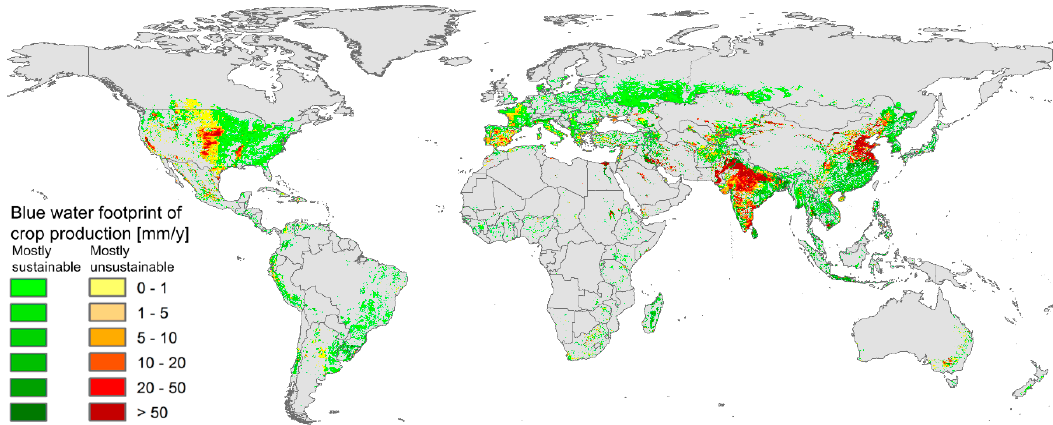
Figure 4. The sustainable (green) and unsustainable (yellow to dark red) parts of the blue WF of global cereals production. Data source from Mekonnen and Hoekstra [81].